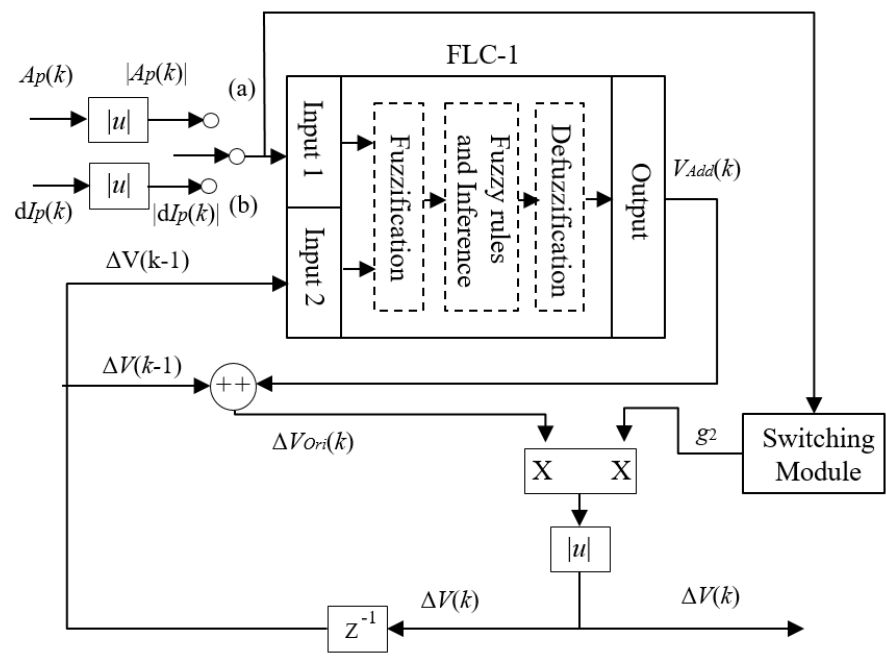
Figure 5. FLC-1 Figure 5. FLC-1 structure.